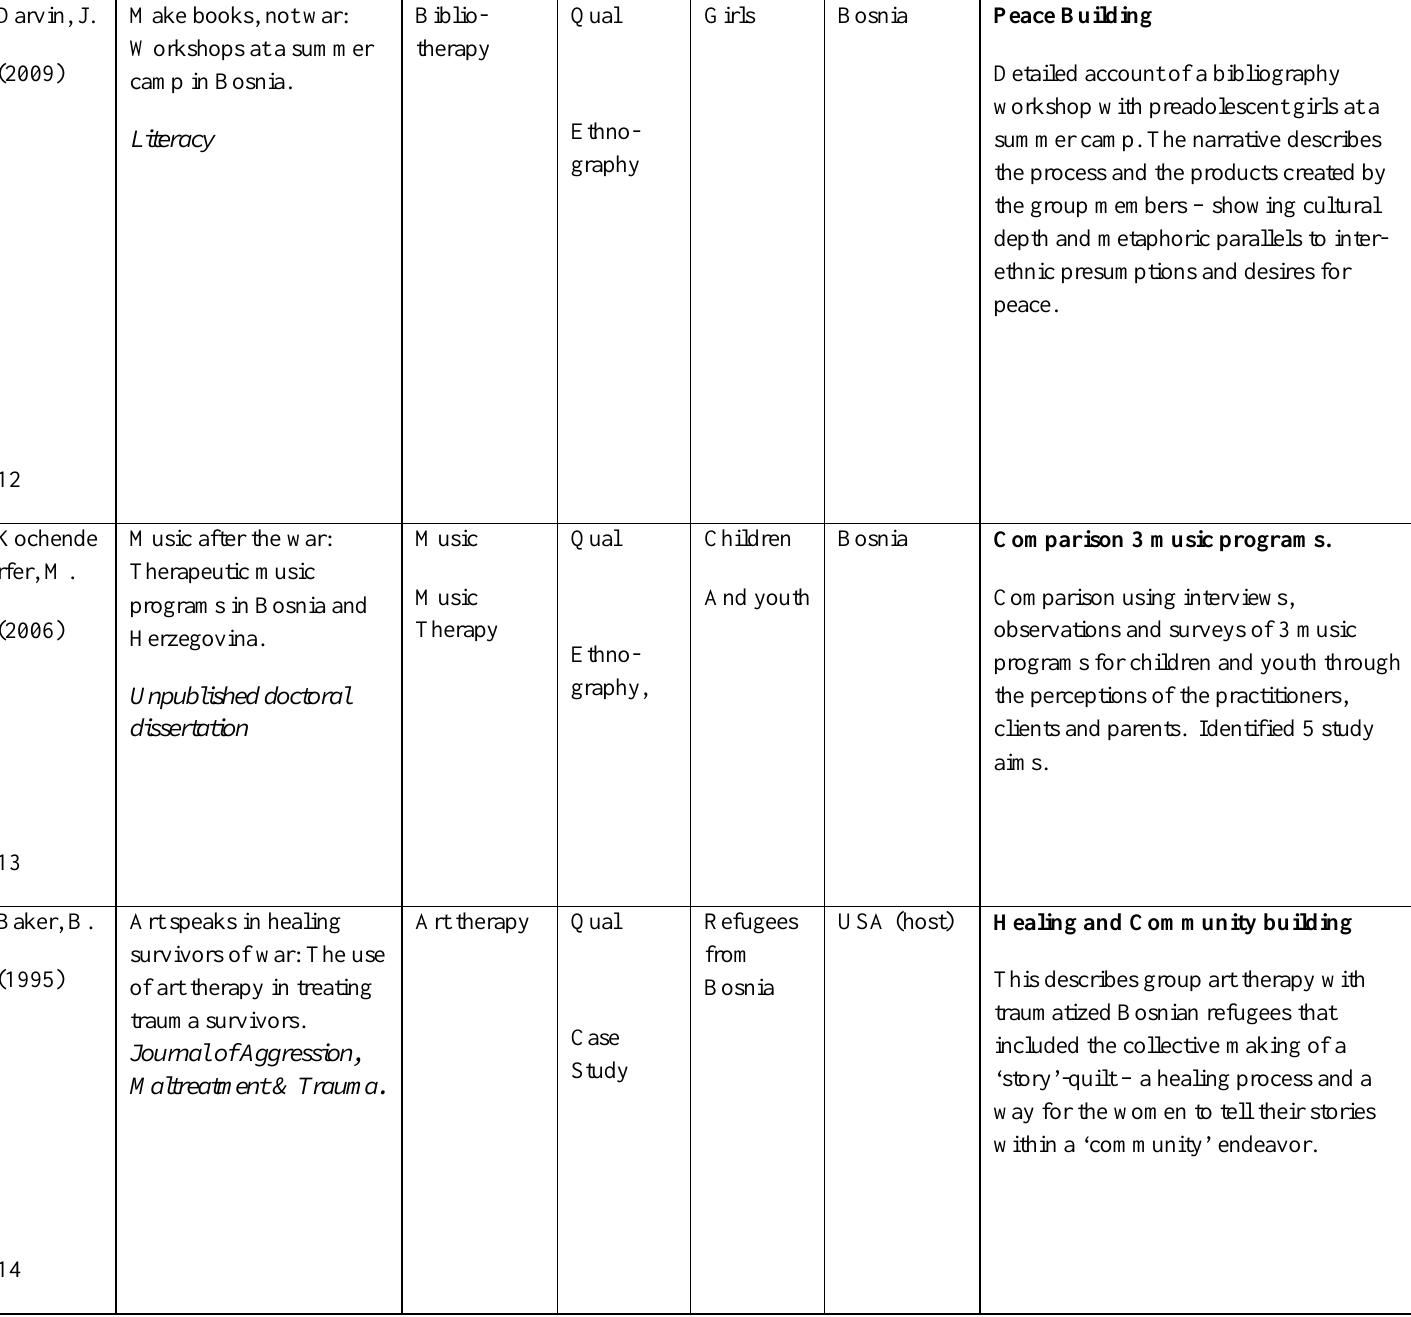
Comparison 3 music programs. Comparison using interviews, observations and surveys of 3